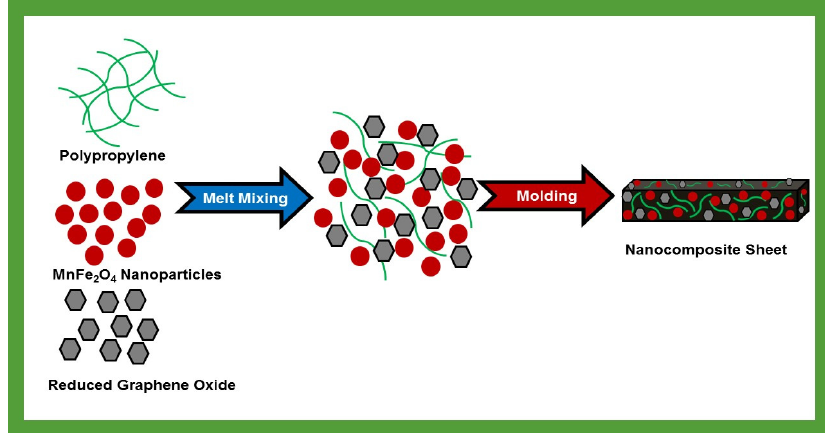
Figure 2. Schematic illustration of the preparation of polypropylene (PP) based nanocomposites embedded with MnFe 2 O 4 spinel ferrite nanoparticles and reduced graphene oxide